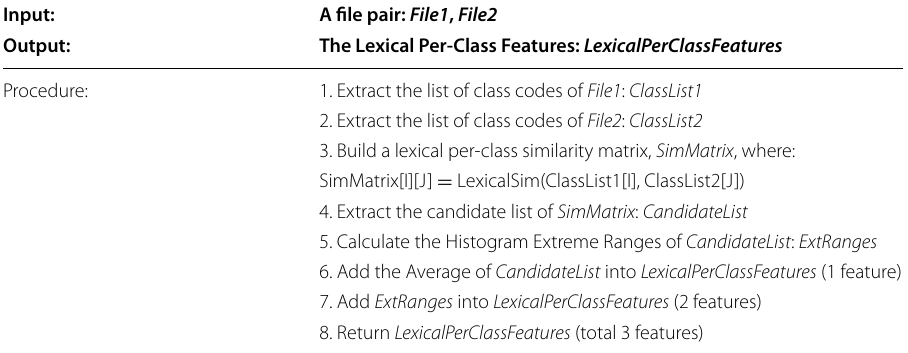
Table 1 The extraction steps of the lexical per-class